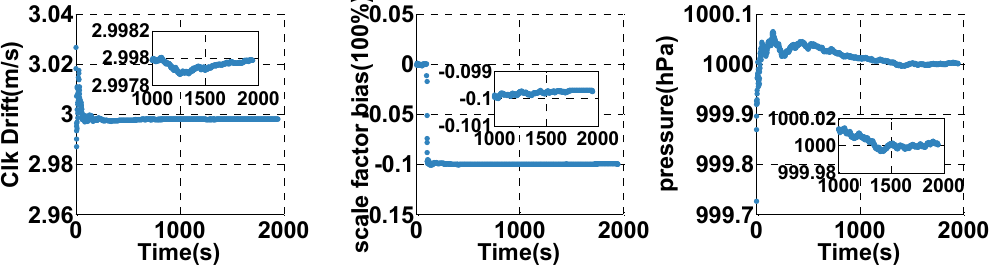
Figure 6. The estimated clock (Clk) drift, error of the odometer’ scale factor, and reference pressure in the open-sky case.